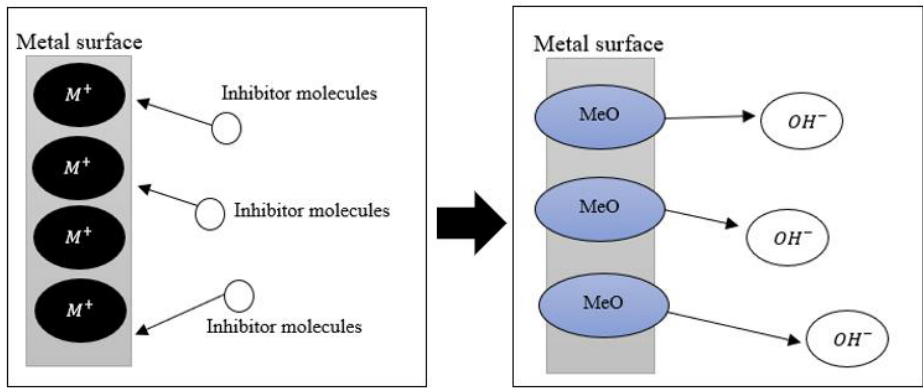
Figure 2. Mechanism of anodic inhibitors.